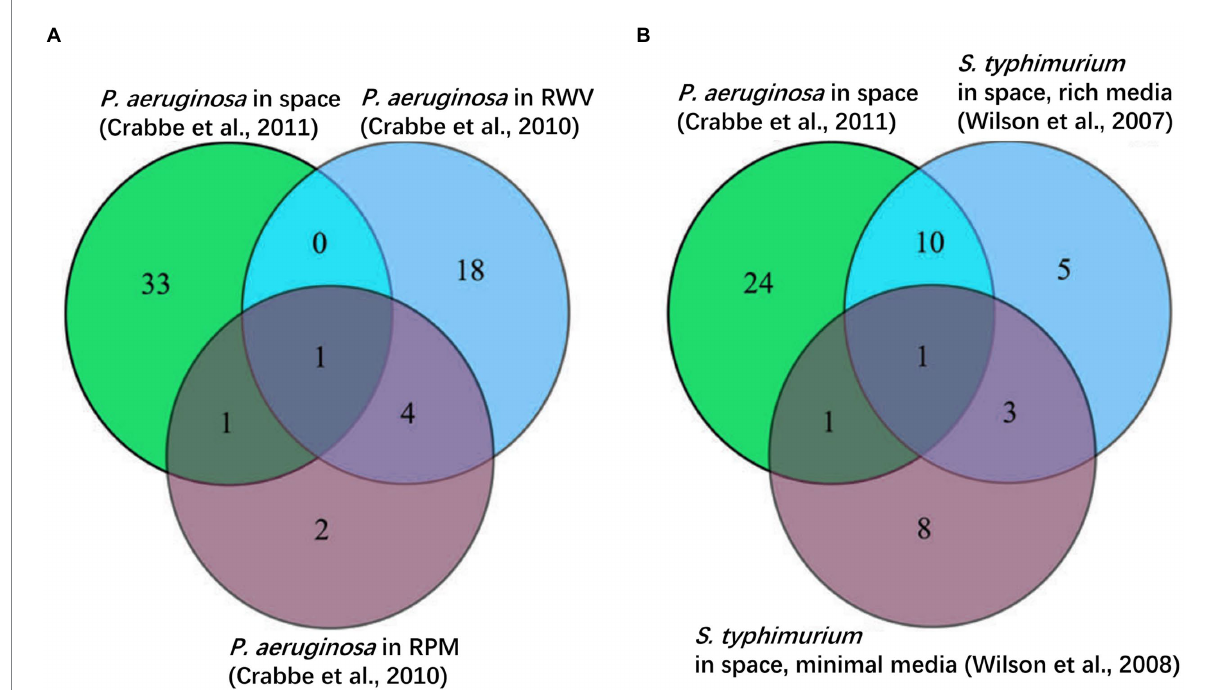
FIGURE 5 Venn diagrams among different experiments showing common altered pathways (modified from a figure of Roy et al., 2016). (A) P. aeruginosa in space, rotating wall vessel (RWV), and random positioning machine (RPM) experiments. Valine, leucine, and isoleucine degradation pathways are common among the three experiments. Flagellar assembly, protein export, ribosome, RNA degradation, TCA cycle, and oxidative phosphorylation are increased in RWV and RPM but decreased in space. (B) P. aeruginosa in space, S. typhimurium in space (rich media), and S. typhimurium in space (minimal media). Ribosome, RNA degradation, protein export, flagellar assembly, methane metabolism, toluene degradation, oxidative phosphorylation, TCA cycle, glycolysis, purine metabolism, and pyrimidine metabolism are the common altered